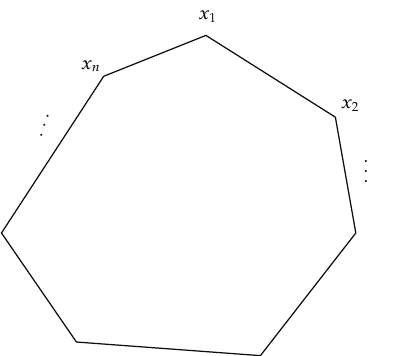
Figure 6: The light-like polygon in which the minimal surface ends is parameterized by the position of the (cid:5) 0. cusps, x i , with x 2 i,i (cid:8) 1